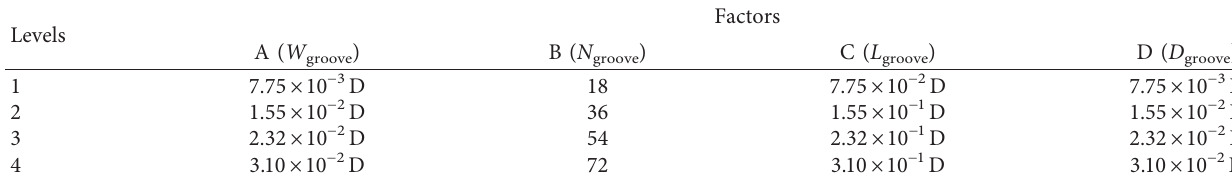
Figure 5: Diagram of groove’s location and size: (a) location; (b) length; (c) number; (d) width and depth. Table 1: Factors and levels of groove.